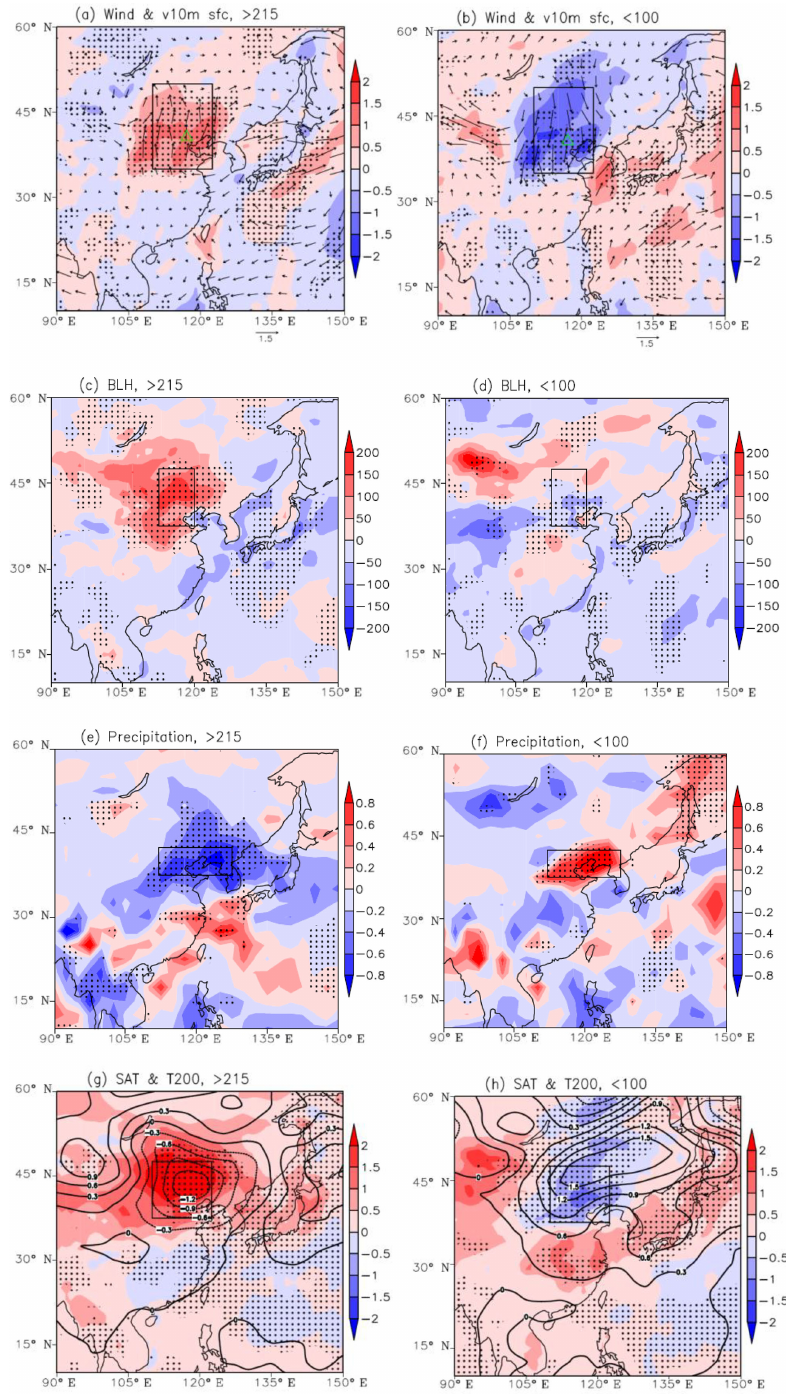
Figure 2. Composite of the meteorological conditions associated with different O 3 events during 2007–2017. Results for MOP (a, c, e, g) and NOP (b, d, f, h) events included (a, b) surface wind (ms − 1 ; arrow) and v wind (ms − 1 ; shading), (c–d) BLH (m), (e, f) precipitation (mm), (g–h) SAT ( ◦ C, shading) and temperature at 200hPa ( ◦ C; contour). The black dots denote the composite results that passed the 95% confidence level. The boxes represent the area used to calculate OWI. These composites were calculated using the ERA-Interim dataset. The green triangle in (a, b) illustrates the location of the Shangdianzi site. The composite results were calculated as the differences between MOP or NOP events and the rest of the events (i.e., all events, excluding MOP and NOP